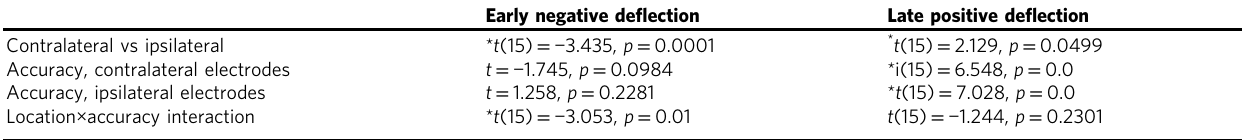
Table 1 Analysis of the early negative and the late positive event-related potentials